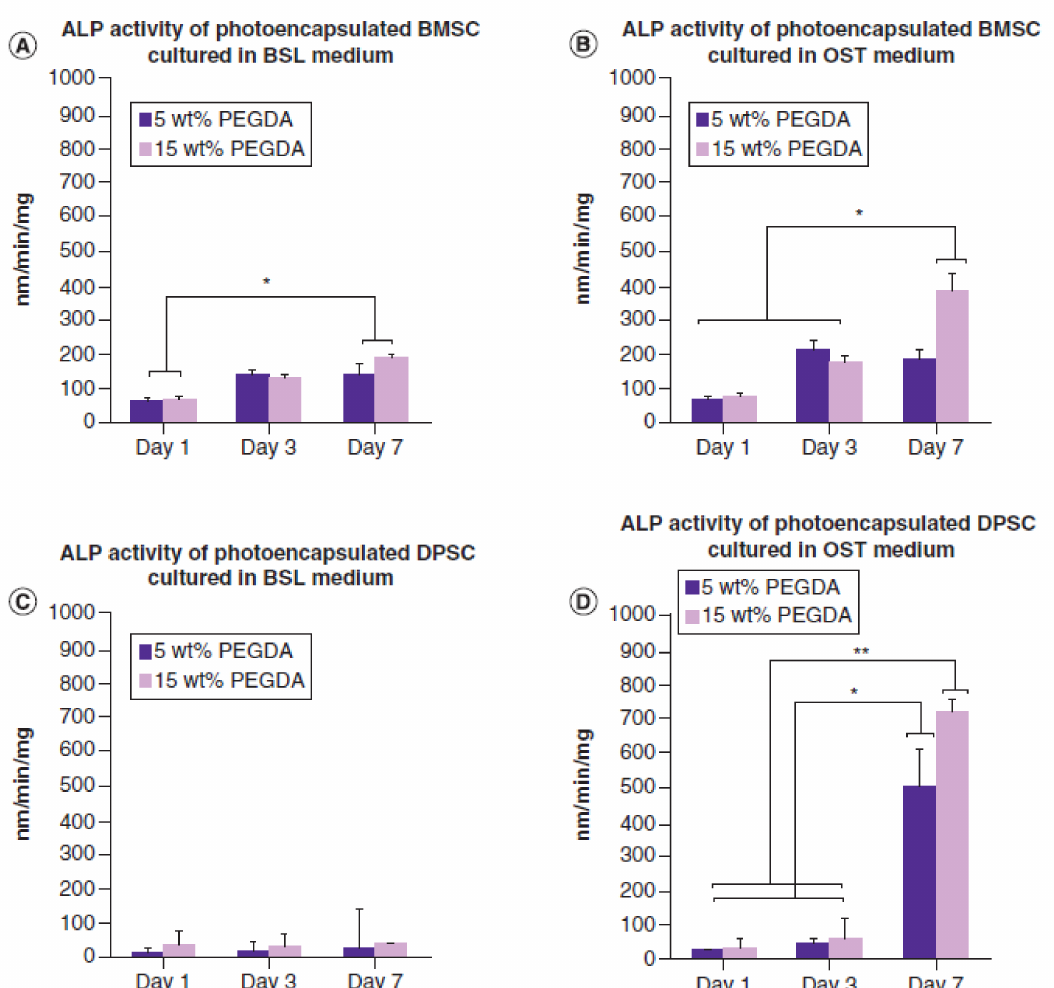
Figure 6. Shows ALP activity of photoencapsulated-MSCs (BMSCs and DPSCs) in 5 or 15 wt% PEGDA hydrogels, cultured in basal (BSL) or osteogenic (OST) medium. ( A ) Photoencapsulated-BMSCs in 5 or 15 wt% PEGDA hydrogels, cultured in BSL medium, show increased ALP activity levels at day 7 compared to day 1. ( B ) photoencapsulated-BMSCs in 15